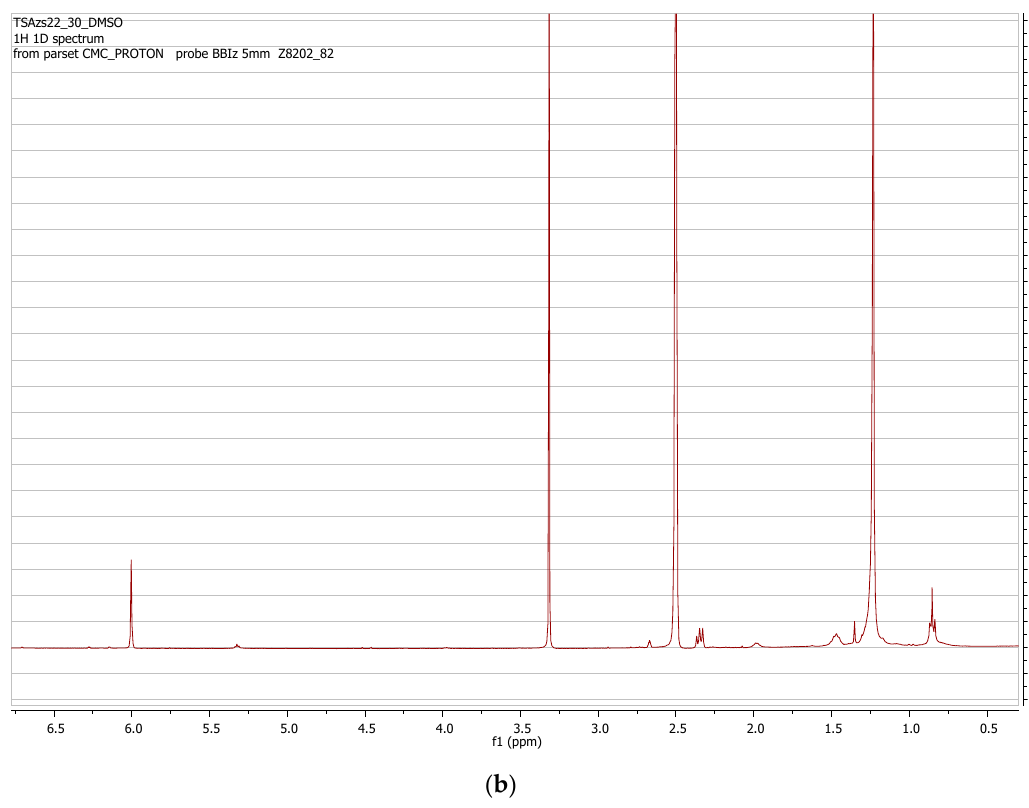
Figure 3. GC chromatogram of the isolated compounds.